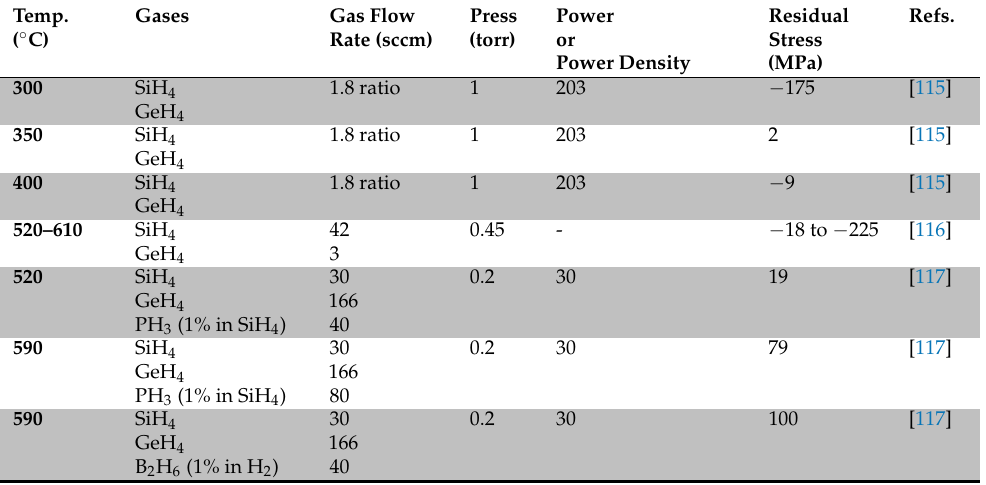
Table 10. ReportedResidualStressesofPECVDSiliconGermaniumasaFunctionofProcessingConditions. Temp. ( ◦ C)